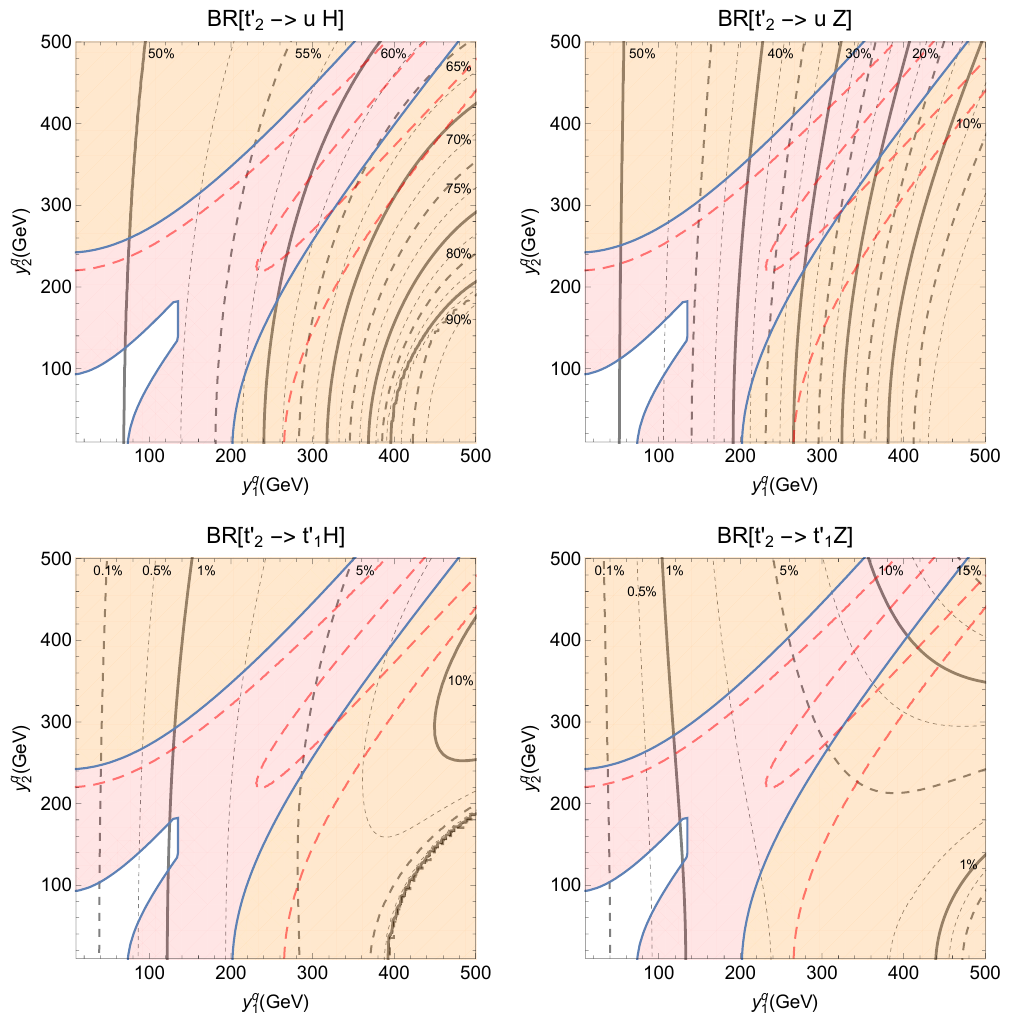
Figure 7 . Branching ratios of t 0 mixing with the up/charm quark. The contours are show for 2 values of the BR spaced by steps of 2 : 5% (unless speci(cid:12)ed). The orange region is excluded for the charm, while the orange plus pink areas are excluded for the up. The dashed line indicate the region excluded by EWPTs for mixing to the